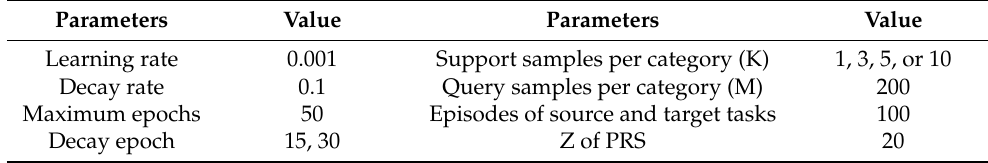
Table 6. Parameter settings of the transductive training